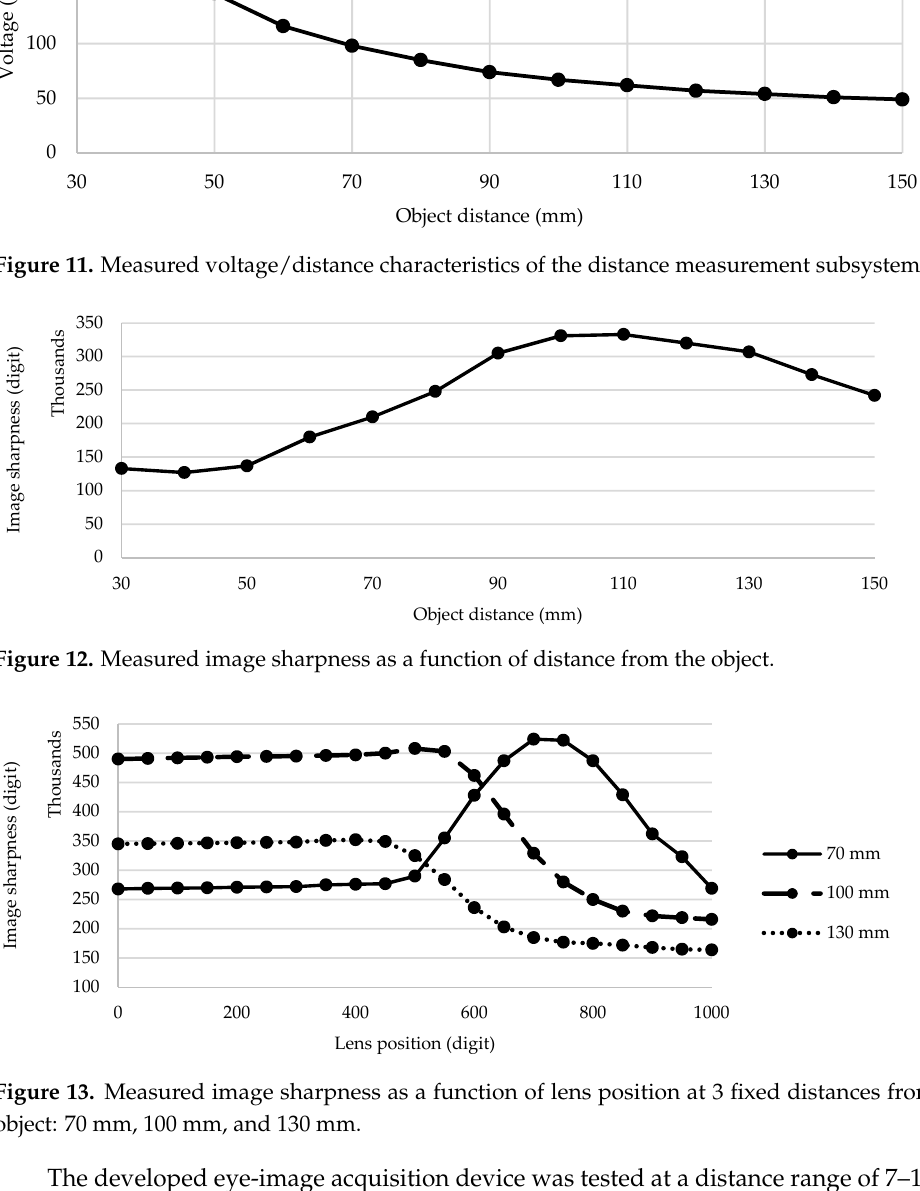
Figure 13. Measured image sharpness as a function of lens position at 3 fixed distances from the object: 70 mm, 100 mm, and 130 mm.